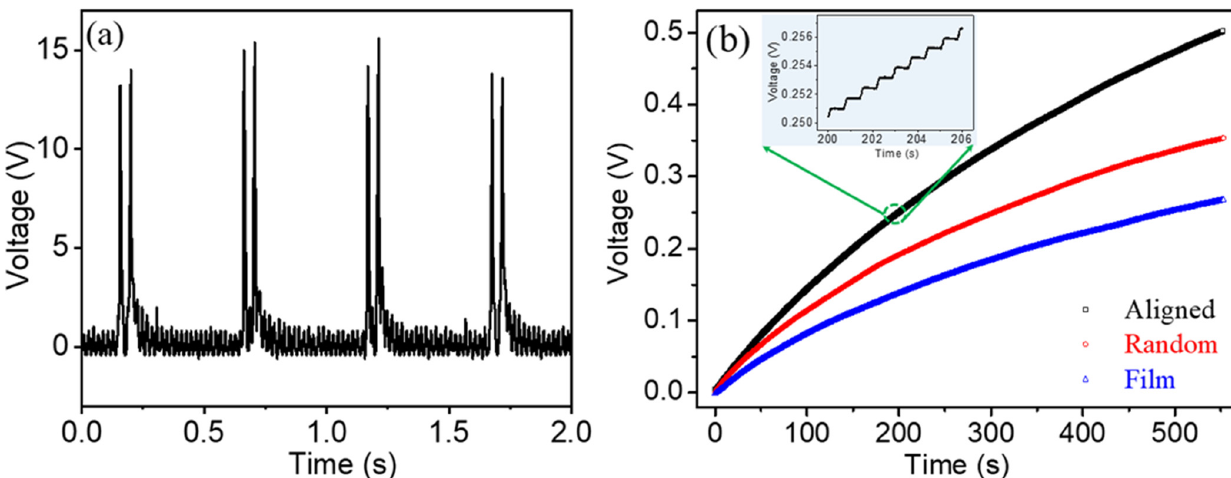
Figure 7. ( a ) Rectified output open-circuit voltage generated by the a-PVDF nanogenerator, ( b ) the time dependent charging curve of a 47 µF capacitor yielded from thick film, r-PVDF, and highly a-PVDF membranes nanogenerators, respectively.